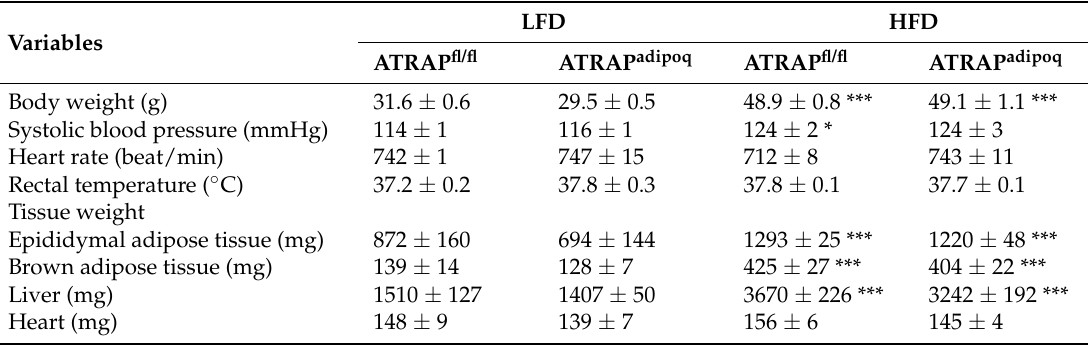
Figure 3. Change in body weight in ATRAP fl/fl and ATRAP adipoq mice fed an LFD or HFD ( n = 9). ∆ , ATRAP fl/fl mice fed an LFD; ▲ , ATRAP adipoq mice fed an LFD; ○ , ATRAP fl/fl mice fed an HFD; ● , ATRAP adipoq mice fed an HFD. Values are the means ± SEM. *** p < 0.001 vs. LFD within the same group. Data were analyzed by two-way repeated measures analysis of variance (ANOVA). LFD: Low-fat diet; HFD: High-fat diet. Table 2. Physiological and metabolic parameters of mice on a low-fat diet or high-fat diet.